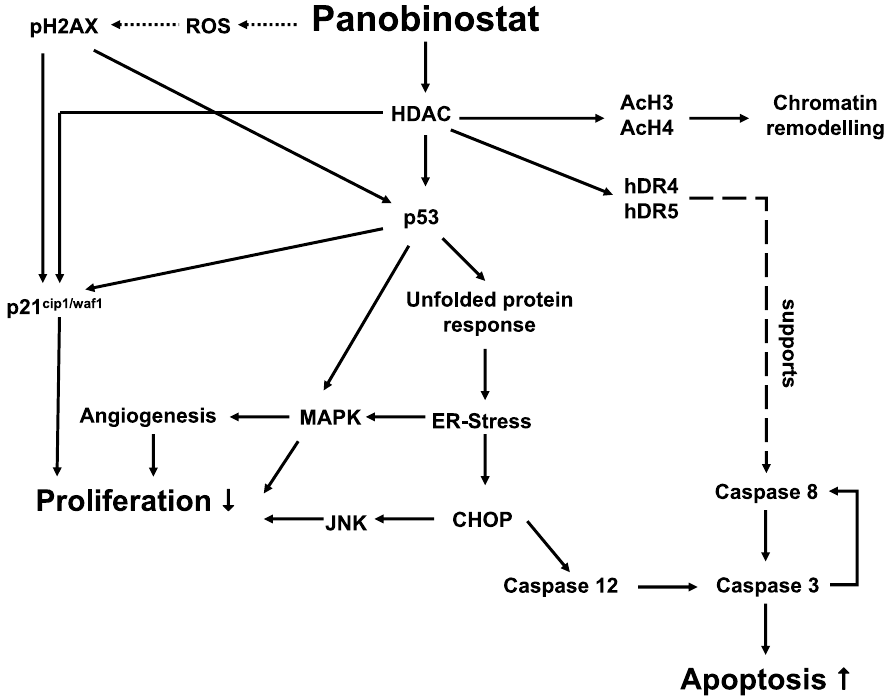
Fig. 8. Signaling pathways involved in panobinostat mediated anti-cancer activity in hepatocellular carcinoma. The inhibition of HDAC by panobinostat leads to an increase in acetylated histones H3 and H4 indicating the chromatin remodeling properties of panobinostat. Dependent on the p53 status, several pro-apoptotic (e.g., TRAIL receptor system, unfolded protein response) and anti-proliferative pathways (e.g., p21 cip1/waf1 ) are activated. Additional effects included the generation of DNA double-strand breaks (pH2AX) and the inhibition of MAPK pathways. These factors also inhibit tumor related neo-angiogenesis and lead to reduced growth of xenografts. The dotted line depicts the generation of reactive oxygen species (ROS) as evidenced in the literature for other HDACi. The increased expression of death receptors (hDR4 or hDR5) may enhance the effect of caspase 8 but is not mechanistically linked to caspase 8 activation (dashed